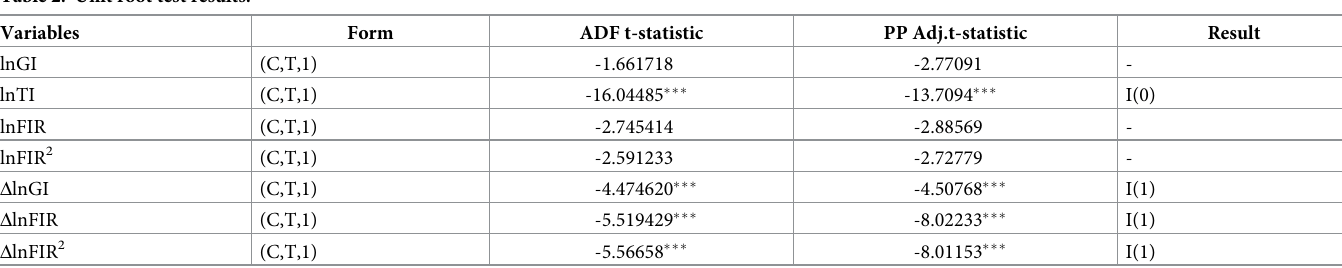
Table 2. Unit root test results.